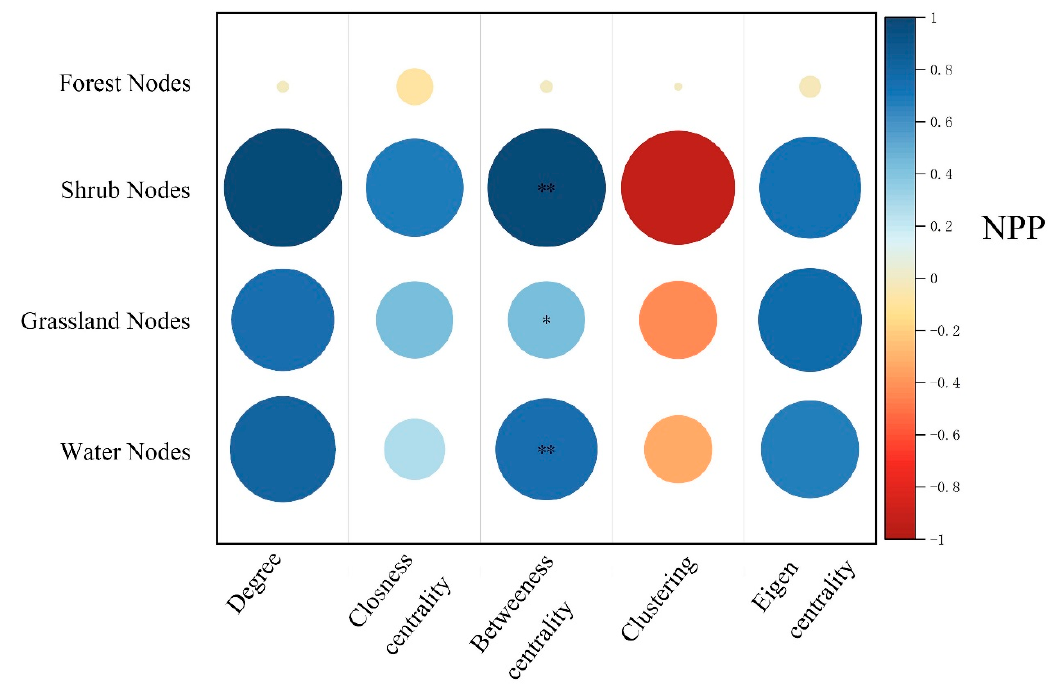
Figure 9. Carbon sink correlation analysis. The asterisks denote statistical significance: * p < 0.05, ** p < 0.01.